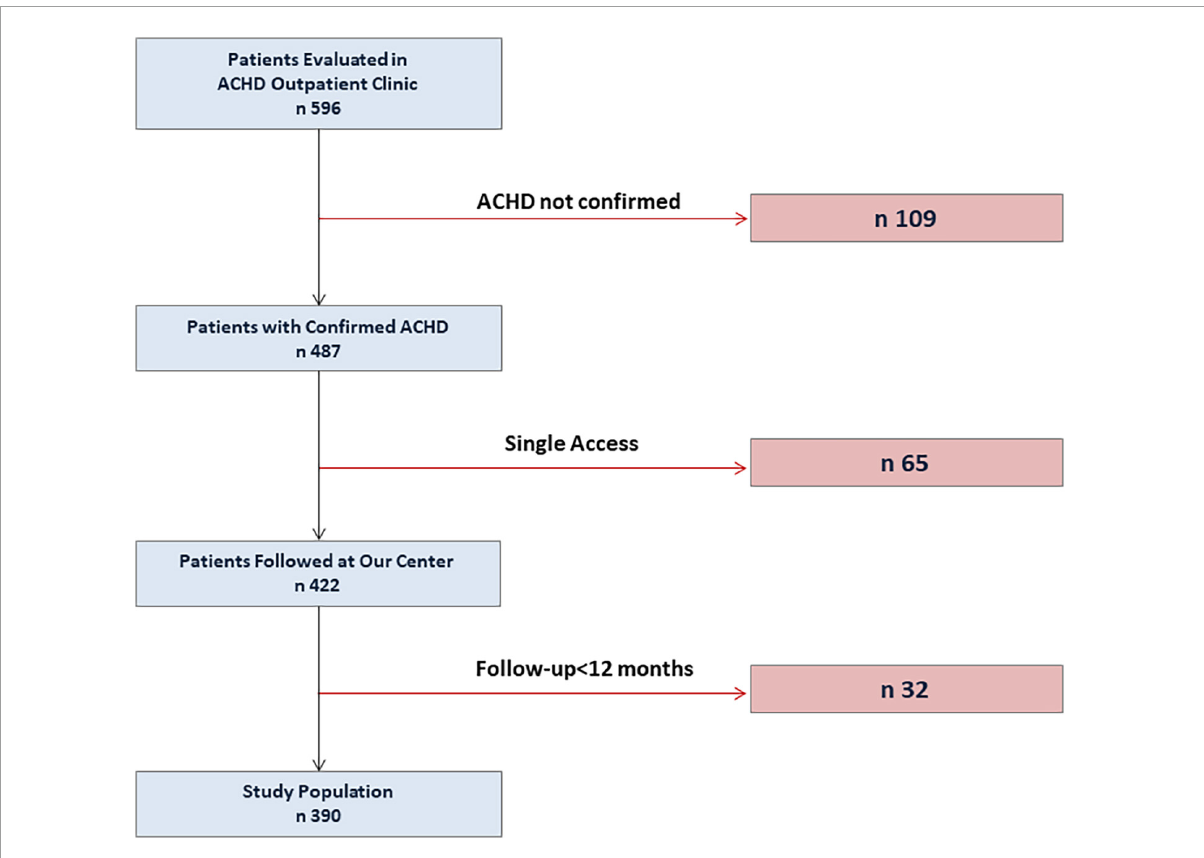
FIGURE1 Study flow-chart. ACHD, Adult congenital heart